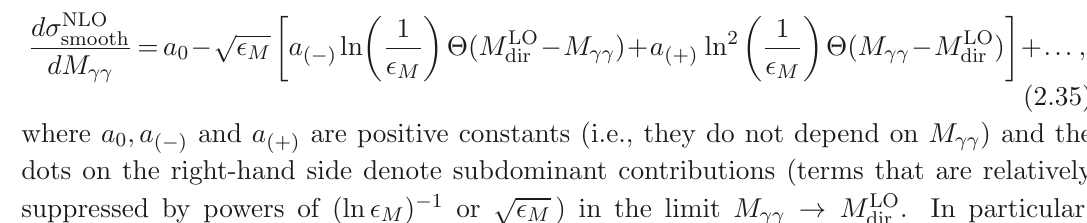
µ R = M γγ / 2 , µ F = 2 M γγ and { }